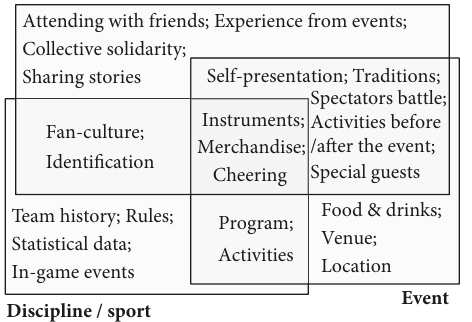
Figure 1: The SPEX Model elements constituting the spectator